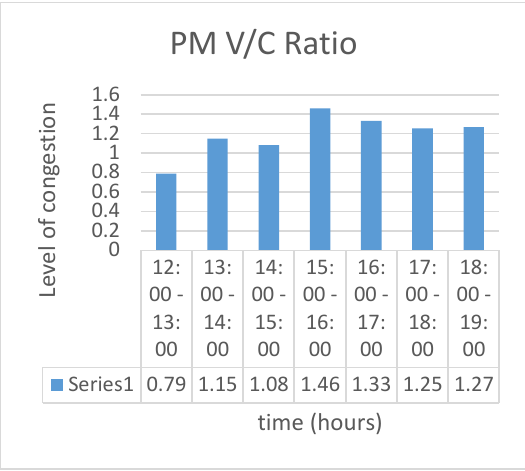
Figure 12: Afternoon-Evening (pm) level of congestion